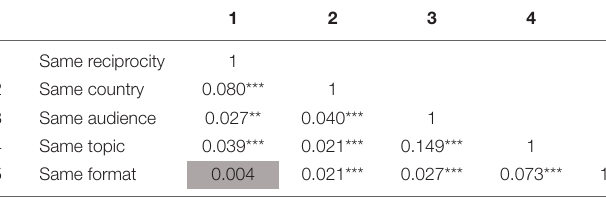
TABLE 5 | QAP for research question 2. TABLE 6 | MRQAP for research question 2.